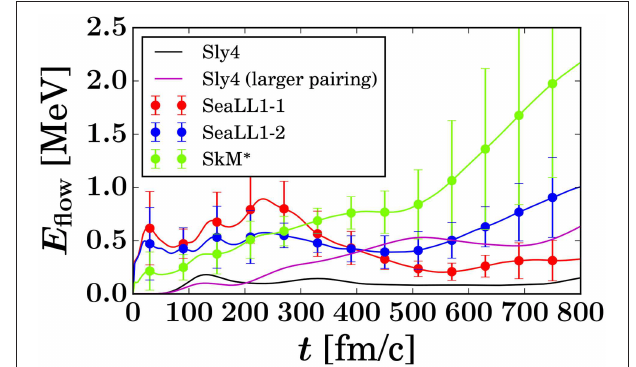
FIGURE 2 | (Color online) the collective flow energy evaluated for NEDFs [42] realistic pairing SLy4 (dash-dot line), enhanced pairing SLy4* (dash line), and for SkM* (dotted and dash-dot lines with error bars), and SeaLL1 (solid and dashed lines with errors bars) sets [17]. The error bars illustrate the size of the variations due to different initial conditions in case of various SeaLL1-1,2 and SkM*-1,2 NEDFs used. In the case of realistic pairing NEDF Sly4 (larger pairing) the time has been scaled by a factor of 1/10. This figure is adapted from the results published in Bulgac et al. [17] under the Creative Commons CC BY license.